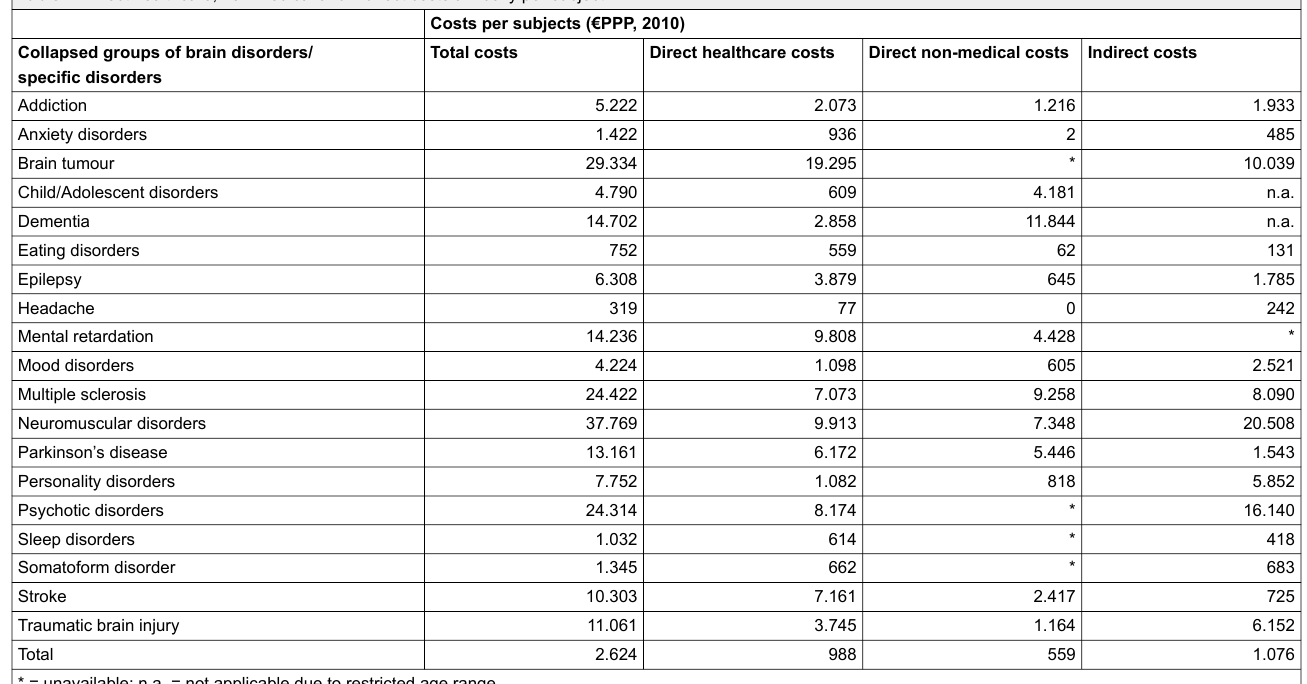
Table 2: Direct healthcare, non-medical and indirect costs annually per subject. Costs per subjects (€PPP,